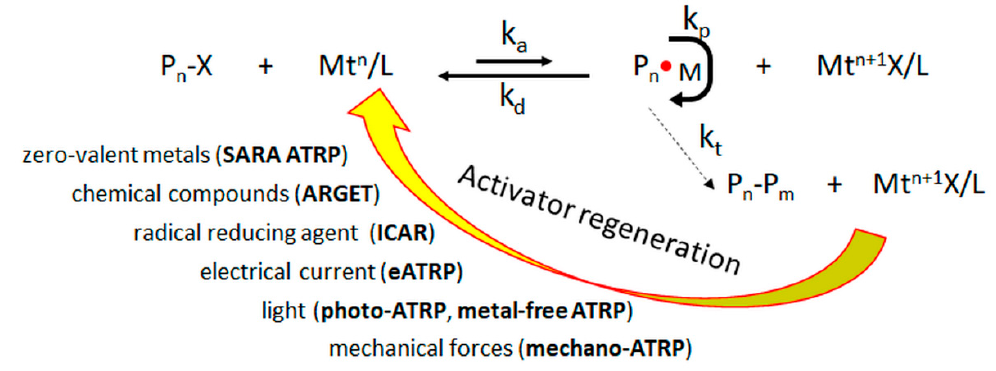
Scheme 1. General scheme of externally controlled atom transfer radical polymerization (ATRP)